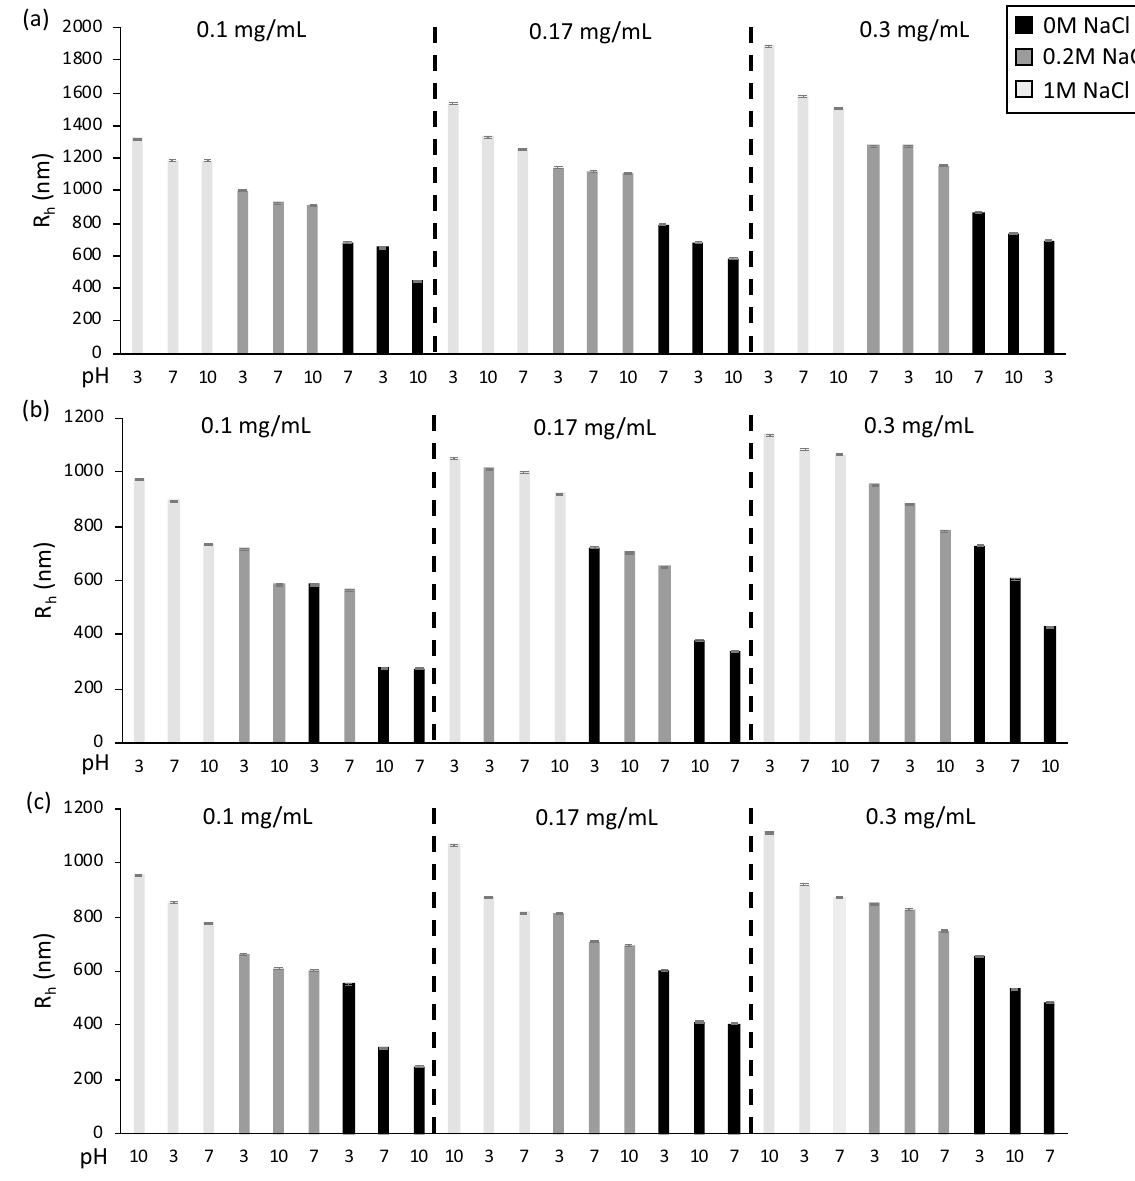
Figure 3. Dynamic light scattering results of aqueous solution samples for the R h, sorted from largest to smallest with respect to polymer concentration of ( a ) ELP, ( b ) ELP/ELP-PEI800, and ( c ) ELP/ELP-PEI10K. Statistical significance between samples can be found in Supplementary Figure